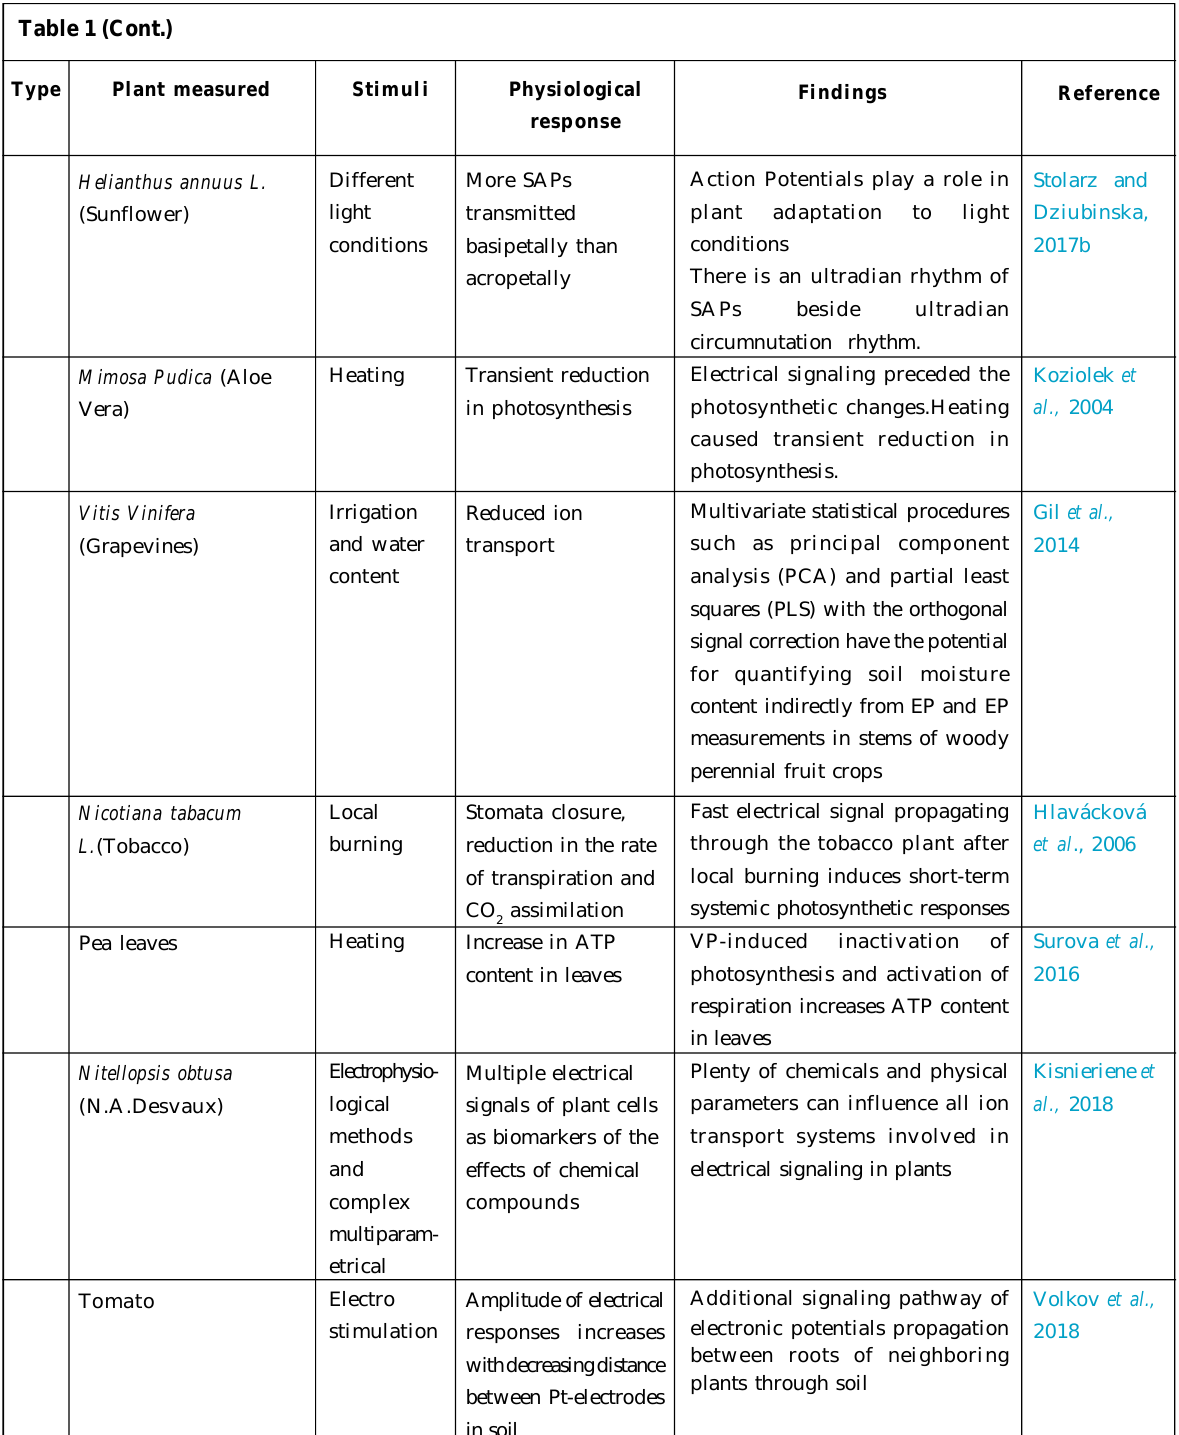
Table 1 (Cont.) Plant